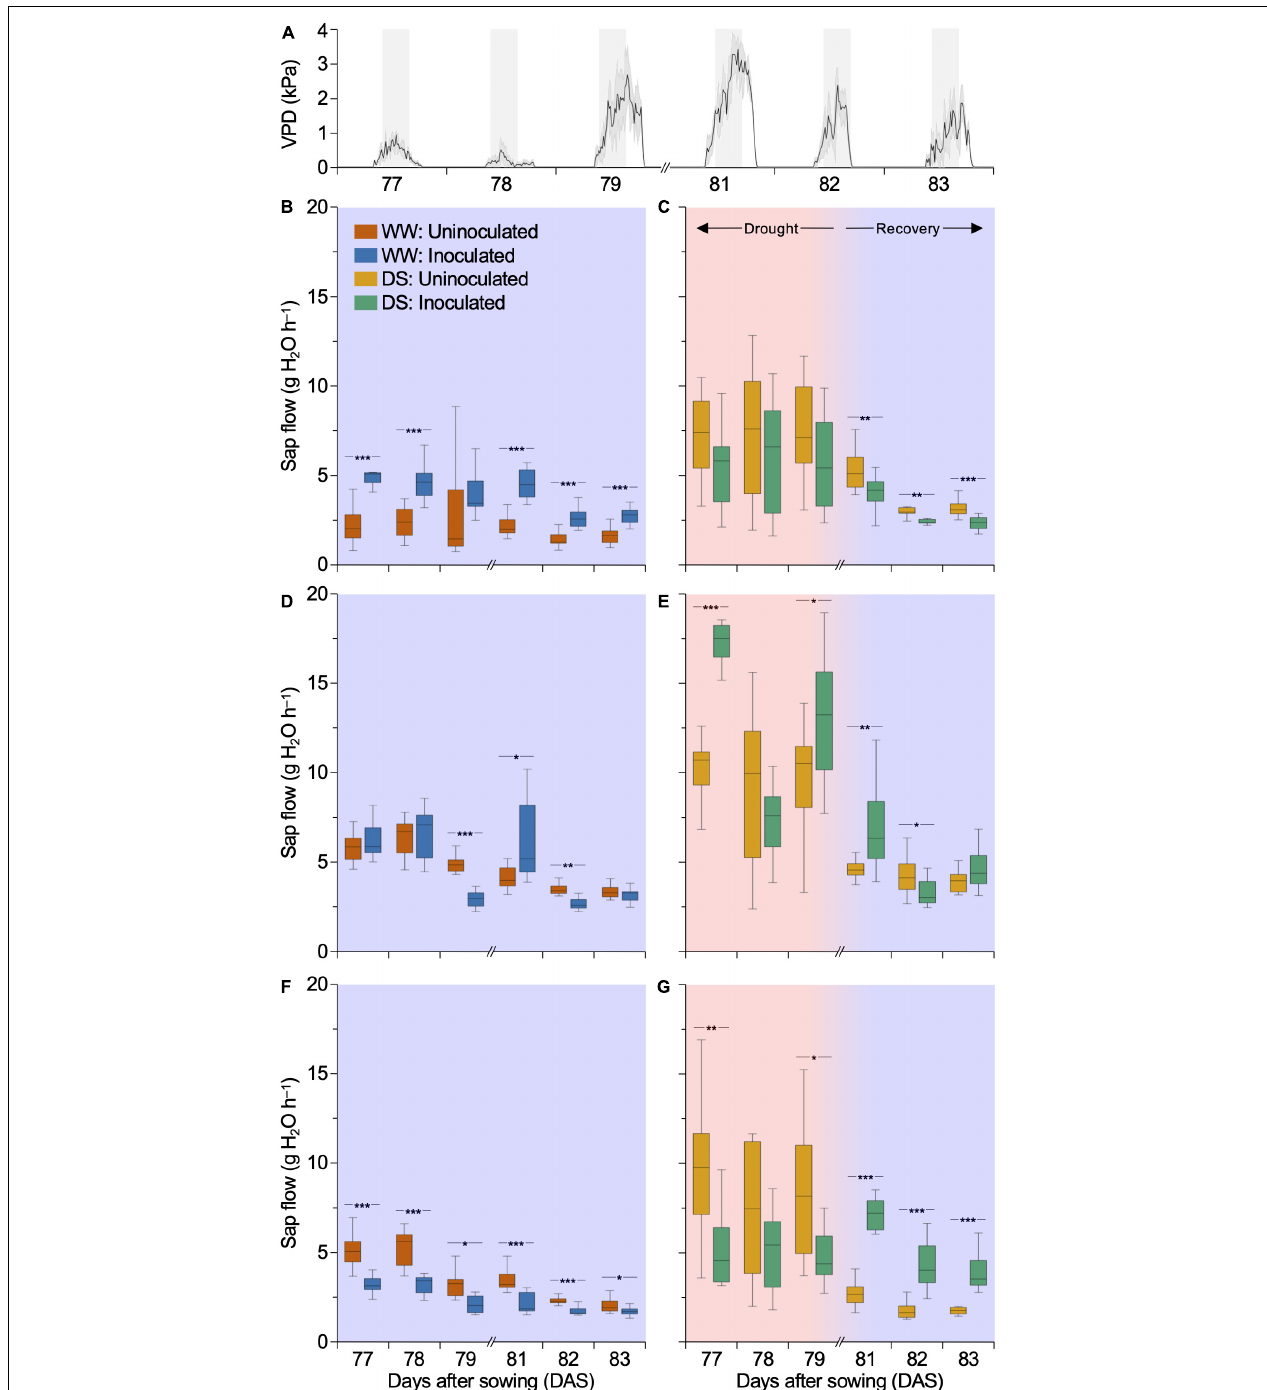
FIGURE 5 | Synthetic community (SynCom) inoculation affects the sap flow of maize hybrids. (A) Fluctuation of VPD (kPa) from 77 to 83 DAS. The gray background highlights daily windows from 10:00 am to 4:00 pm, periods considered to measure sap flow of DKB177 (B,C) , SX7341 (D,E) , and P3707VYH (F,G) . Box plots are shown for WW- (B,D,F) and DS-treated/rehydrated (C,E,G) plants. Rehydration was performed at 80 DAS. (B) In WW, SynCom leads to an increase in DKB177 sap flow by up to 2.22 × . (C) Inoculated DKB177 plants tended to have their sap flow reduced in late stages of DS (77–79 DAS). During recovery (81–83 DAS), this reduction significantly reached up to 25.9%. (D) SX7341 presented an undefined pattern of sap flow under WW the regime. (E) A lack of pattern was also found during the DS and rehydration periods. (F) WW-treated P3707VYH had its sap flow reduced by up to 39.7% when inoculated, the same effect found in DS (G) . (G) During recovery, SynCom inoculation led to a shift in sap flow of P3707VYH with an increase of up to 2.57 × compared to the control. VPD: vapor-pressure deficit; WW, well watering; DS, drought stress; DAS, days after sowing. * P ≤ 0.05, ** P ≤ 0.01, and *** P ≤ 0.001.